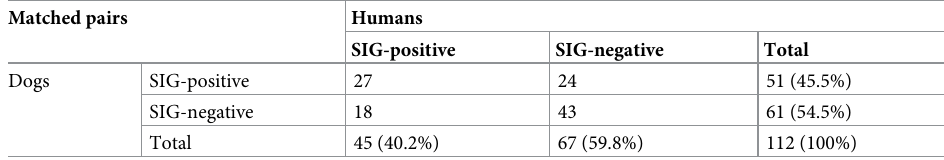
Table 1. 2x2 contingency table used to perform the Pearson’s chi-square test with Yates’ continuity correction and odds ratio on the SIG prevalence data in humans and dogs. Matched